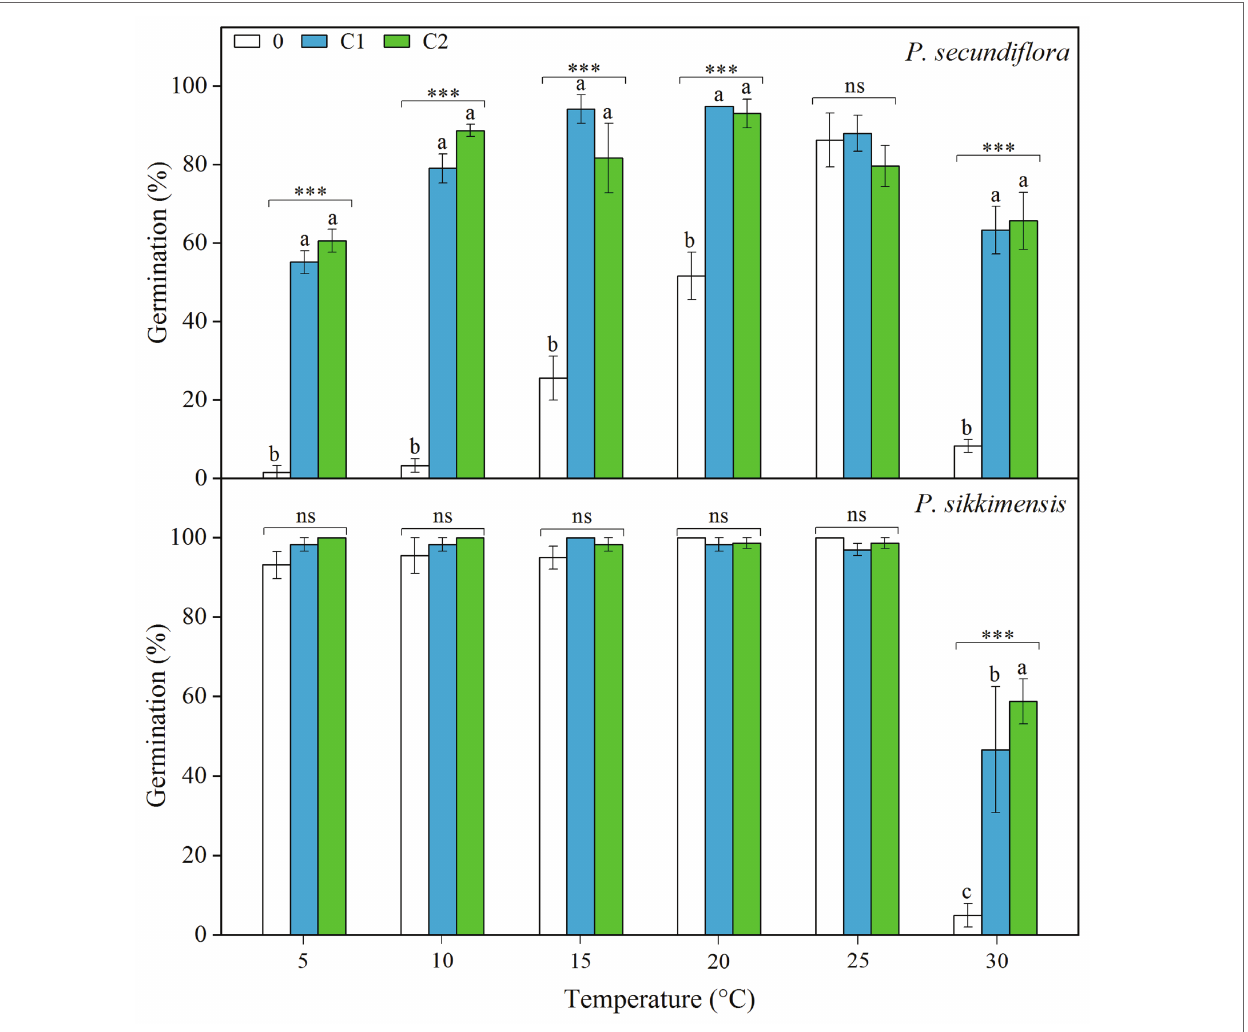
FIGURE 3 | Effects of temperatures and cold treatments (0, control; C1 and C2 cold stratification at 1 ° C in light for 4 and 8 weeks, respectively) on germination of Primula secundiflora and Primula sikkimensis . Error bars indicate SE for three replicates of 20 seeds. Temperatures, treatments, and their interaction are statistically significant ( p < 0.001 by GLM) in these two species. Post hoc pairwise t-test comparisons (with Bonferroni adjustment) were carried out for each germination temperature. ∗∗∗ Indicates a statistically significant difference at p < 0.001, while ns indicates the lack of significant differences between germination percentage at the same temperature for the three treatments. Different letters indicate significant differences at p < 0.05 at each